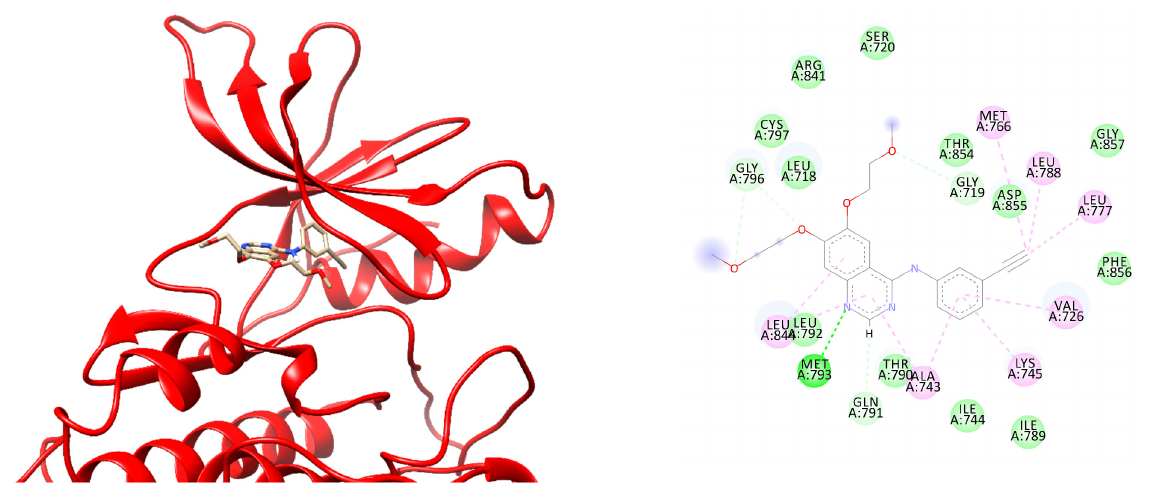
11 of 16 Table 3. Binding free energy (kcal/mol) of erlotinib to the wild-type and mutated EGFR TK.